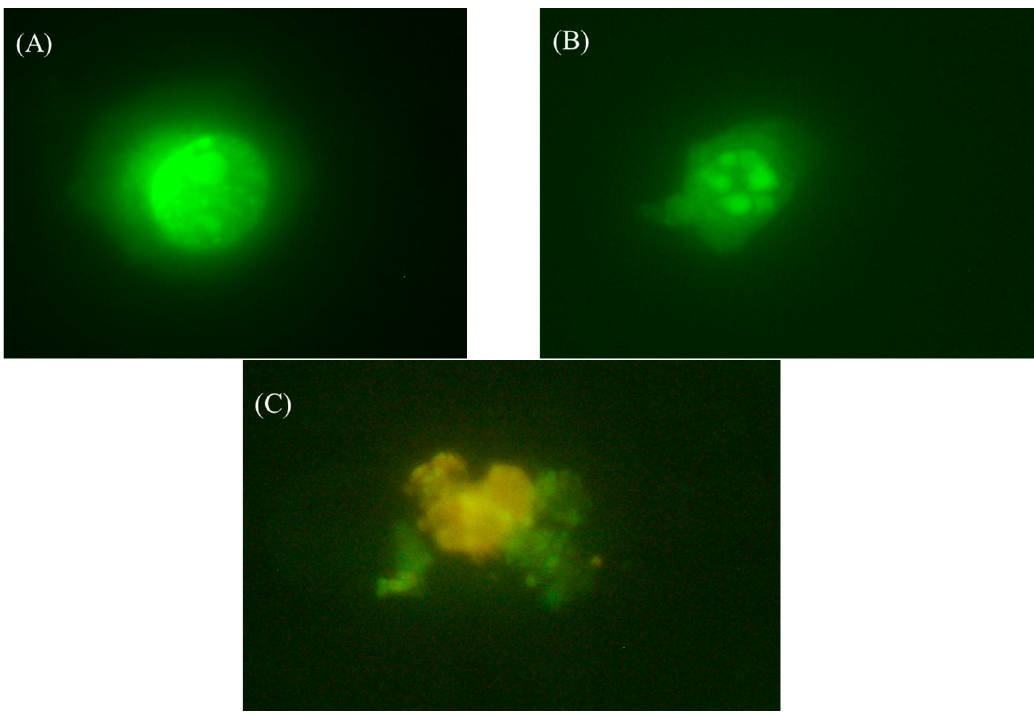
Figure 10. Representative fluorescence microscopy images of viable ( A ); apoptotic ( B ) and necrotic ( C ) human vaginal epithelial cell CRL 2616 incubated with CS/lGP at a concentration of 1.0 mg·mL − 1 after 4 h incubation (magnification 1000×).